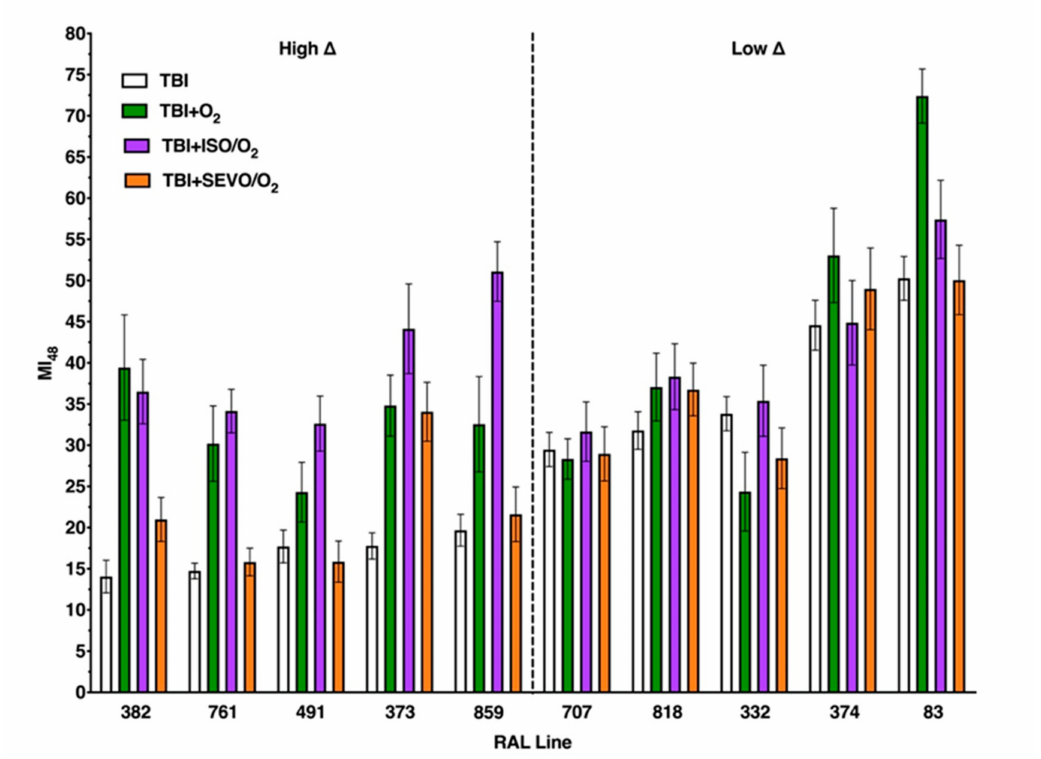
Figure A1. Excess mortality from exposures to O 2 , ISO / O 2 , and SEVO / O 2 48 h after TBI; 10 RAL lines are arranged from left to right by increasing MI 48 from TBI. We classified them into high ∆ (left) and low ∆ (right) groups based on the excess mortality from ISO / O 2 exposure after TBI. The change in MI 48 varied among exposures to O 2 , ISO / O 2 , and SEVO / O 2 and generally replicated the MI 24